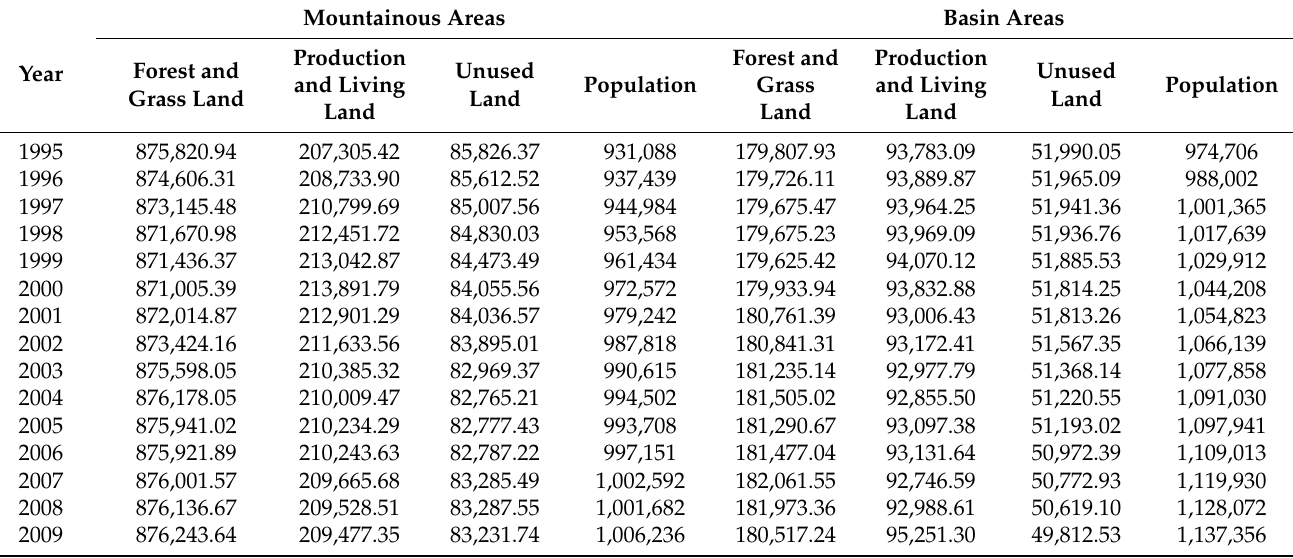
Table 1. Land-type area and population changes in mountainous and basin areas of Yuxi City from 1995 to 2018 (unit: hm 2 , person).